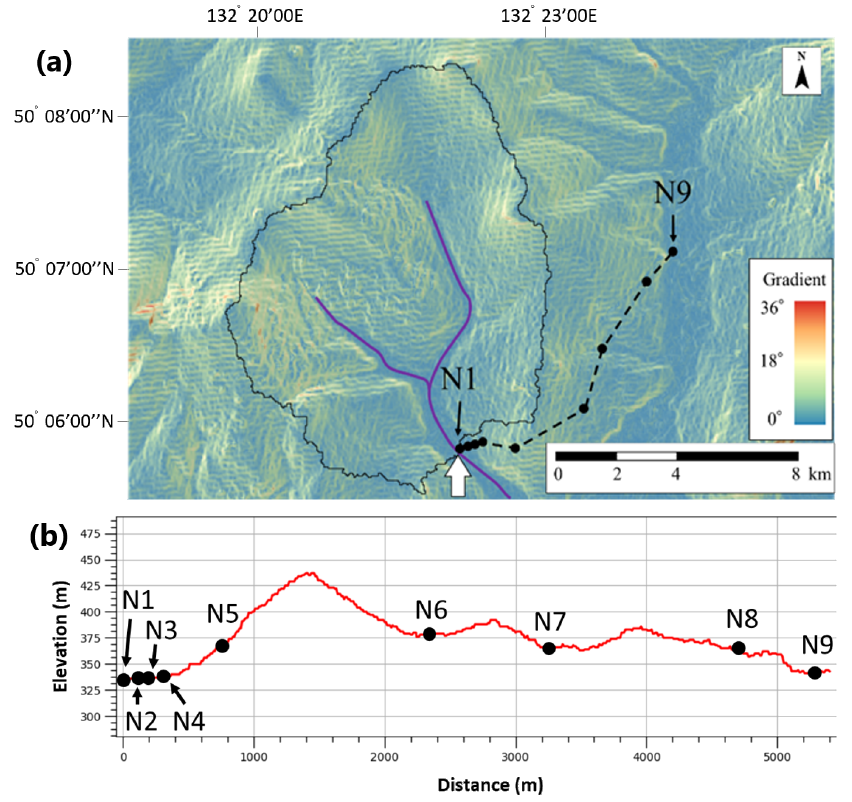
Figure 2. ( a ) nine sampling points for soil pore waters (N1–N9) in the Sofron River and neighboring area. This map is colored by gradient (degree) to clearly show terrain characteristics. Area enclosed with a black line shows the Sofron watershed, and the white arrow denotes the sampling site of the Sofron River. This map was created by the authors based on a 30 m resolution digital elevation model (DEM) provided by the Japan Aerospace Exploration Agency (JAXA); ( b ) topographic profile through the sampling points for soil pore